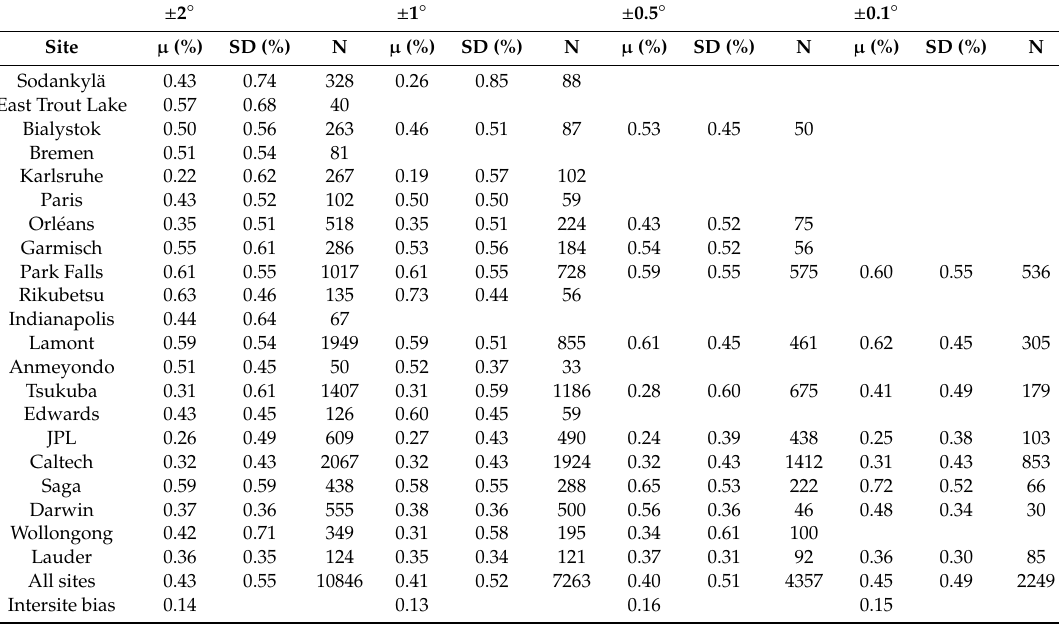
Table A2. Mean ( µ ) and standard deviation (SD) of the relative di ff erence in the ratio component between GOSAT and TCCON and the number of matched GOSAT and TCCON data points (N) for each TCCON site. Results for four di ff erent matching criteria are shown: GOSAT data within ± 2 ◦ , ± 1 ◦ , ± 0.5 ◦ , and ± 0.1 ◦ latitude / longitude boxes centered at each TCCON site. Only sites having more than 29 data points are shown. The GOSAT data obtained under conditions where cloud-free scenes were expected (cloud fraction = 0 and normalized 2 µ m band radiance ≤ 1) were used. Intersite bias is calculated using the same sites as in the case of matching criteria of ± 0.1 ◦